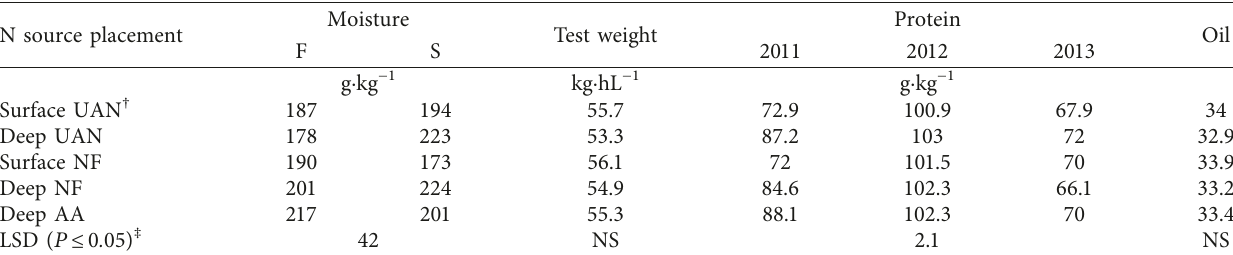
Table 6: Corn grain moisture, test weight, protein, and oil concentration response to nitrogen sources/placements at 84kg · N · ha − 1 . Data were combined over factors or years in the absence of a significant interaction. Surface treatments were no-tillage with surface applied nitrogen and deep treatments were strip tillage with deep banded nitrogen application.